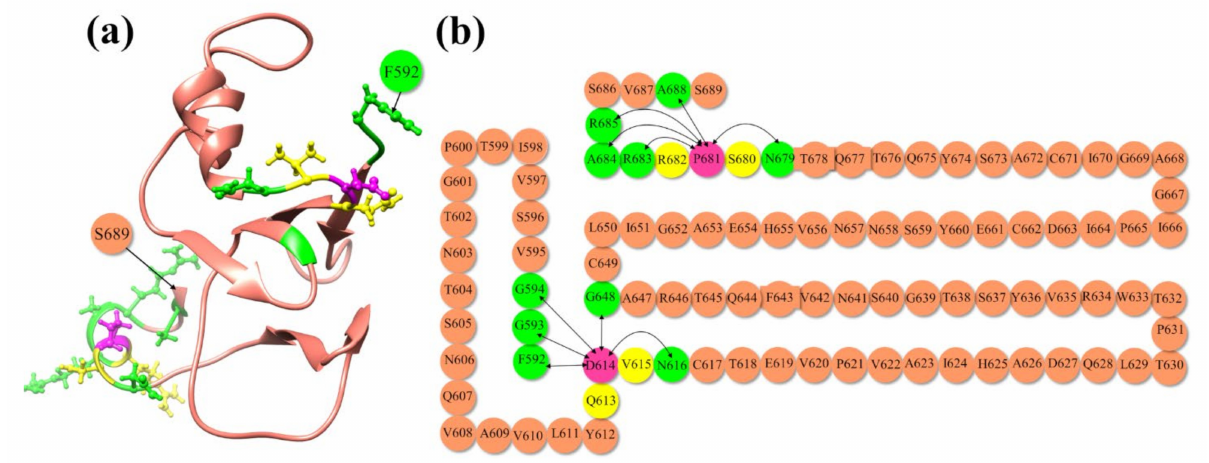
Figure 3. Interaction of D614 and P681 to their NN and NL AAs in WT SD2-FP model. ( a ) Ribbon structure from residue F592 to S689. ( b ) Sketch of AA sequence from F592 to S689 showing AABP interaction for D614 and P681 with joining lines. Both D614 and P681 are shown in pink color with its NN in yellow and NL interaction in